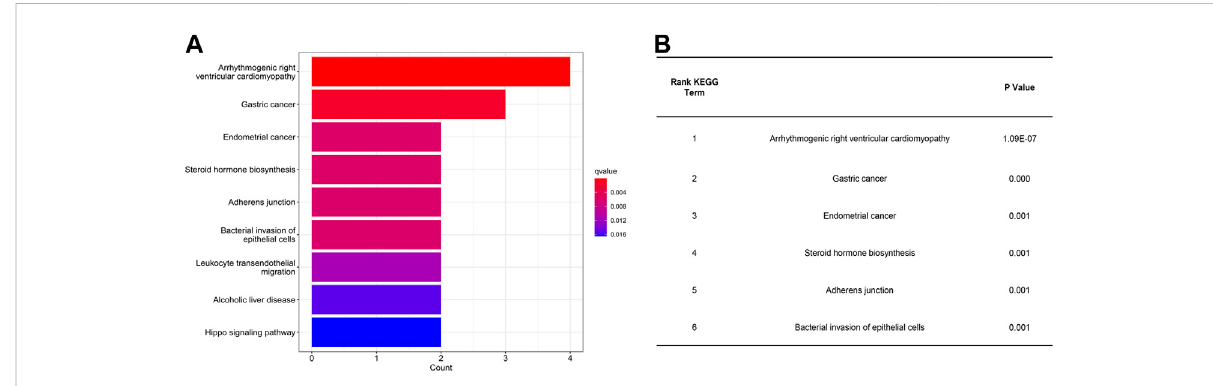
FIGURE 3 Most important interaction between 18 β -GA and in fl ammation according to KEGG pathway analysis. (A) Summary of genes expressed signi fi cant differentially. (B) Forward 6th important enrichment signaling pathways between 18 β -GA and in fl ammation by KEGG pathway